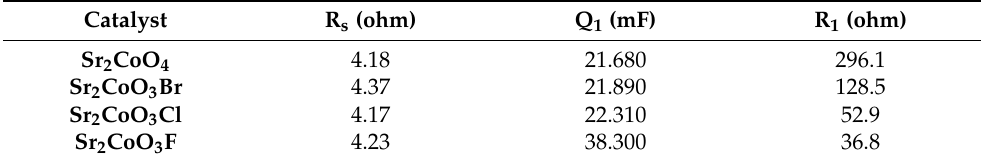
Table 4. Impedance parameter values derived from the fitting of the equivalent circuit for the impedance spectra of the oxyhalides catalysts recorded in 1.0 M NaOH solution at 1.55 V vs. HRE and within the frequency range of 0.01 to 1.0 MHz with a 20 mV amplitude.